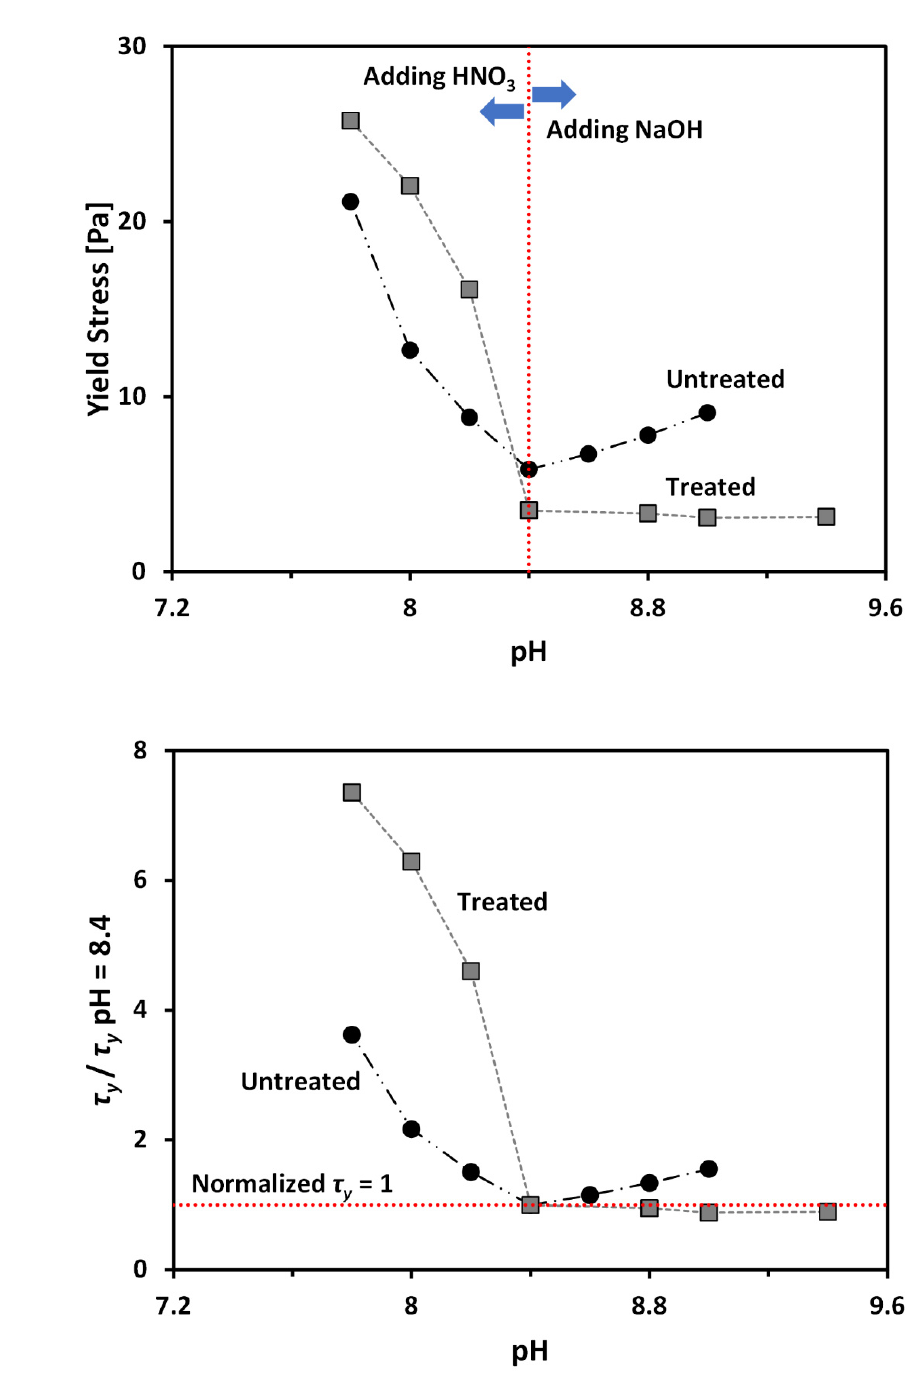
Figure 6. Effect of pH on the yield stress of treated and untreated clays: ( a ) variation of yield stress; and ( b ) variation of normalized yield stress (yield stress/yield stress at pH of 8.4).